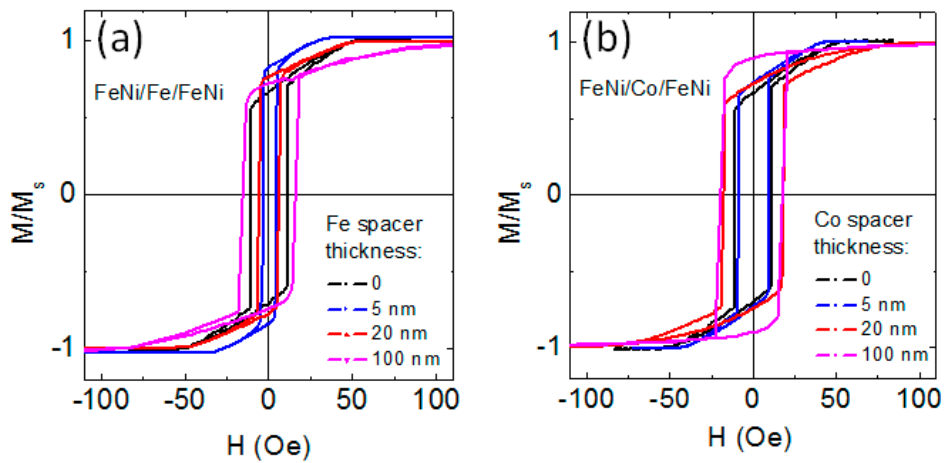
Figure 8. Magnetic hysteresis loops of FeNi(170 nm)/Fe/FeNi(170 nm) ( a ) and FeNi(170 nm)/Co/FeNi(170 nm) ( b ) trilayers with different thicknesses of Fe and Co spacers indicated by the